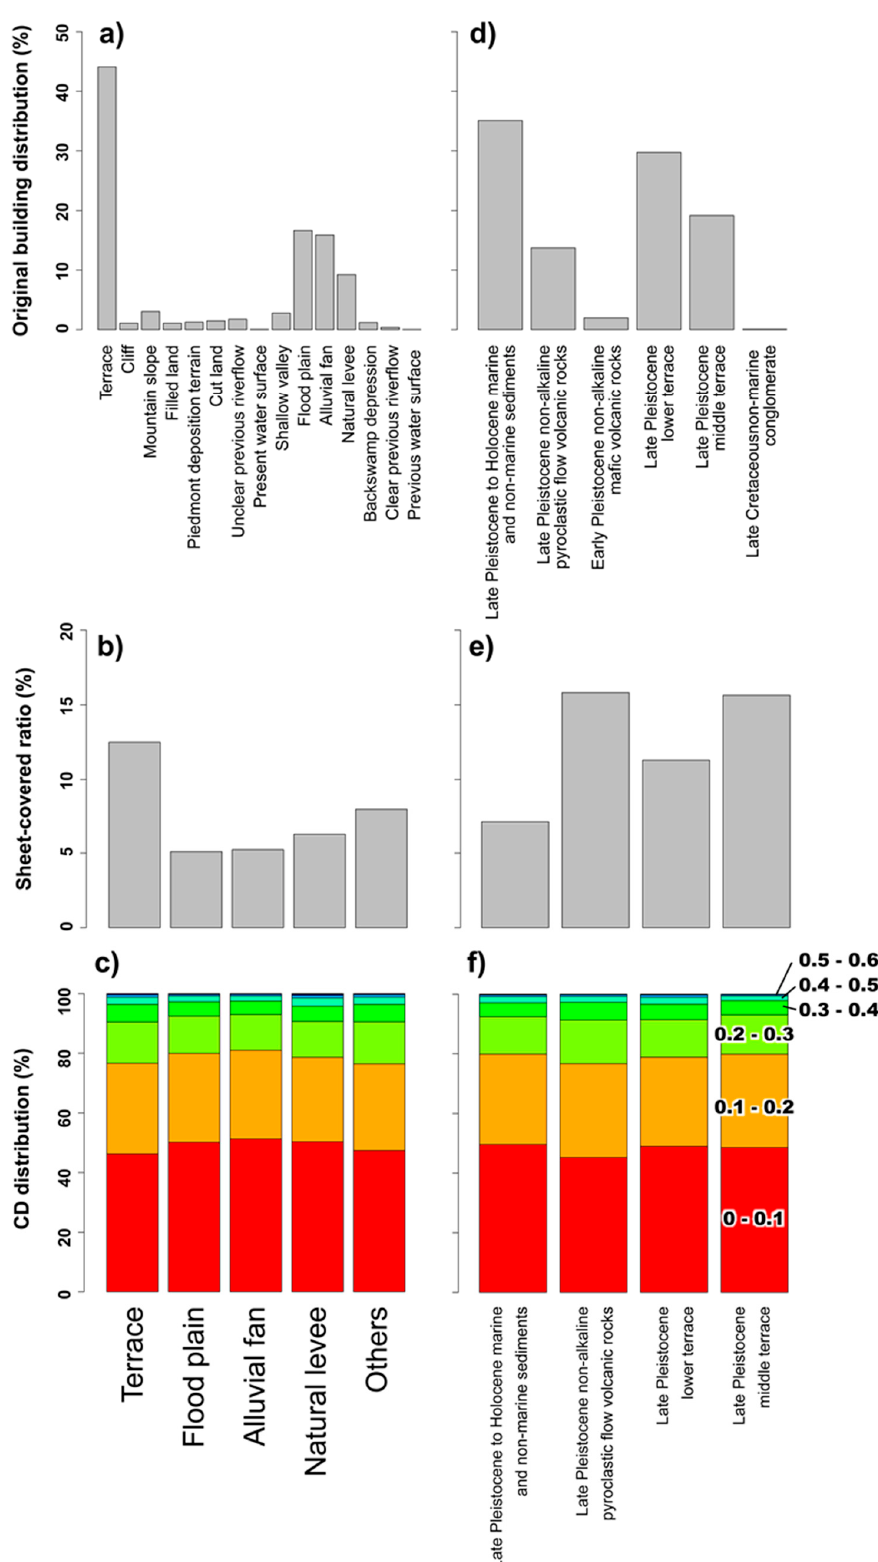
Figure 5. ( a ) Original distributions of entire buildings, ( b ) sheet-covered ratios, and ( c ) numerical ratios of coherence decrease (CD) for whole buildings in each geomorphological classification shown in Figure 4c. Those classified into each geological classification (Figure 4b) are shown in ( d – f ), respectively. Several classification groups with few buildings are omitted in ( b , c , e , f ).